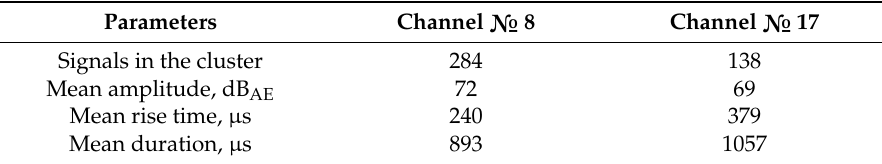
Figure 3. Waveforms corresponding to clusters centers of mass, for acoustic emission (AE) signals from channels: ( a ) channel #8; ( b ) channel #17. Table 1. Parameters of clusters for channels 8 and 17.